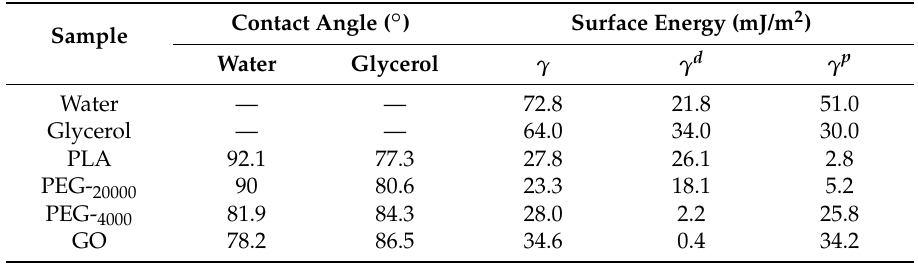
Table 3. The values of component couple surface energies and binding energies of the